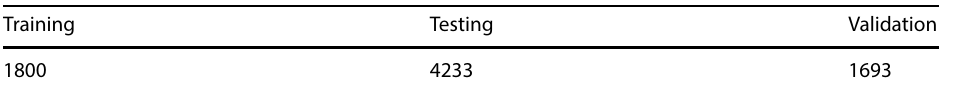
Table 1 U-Net train-test split